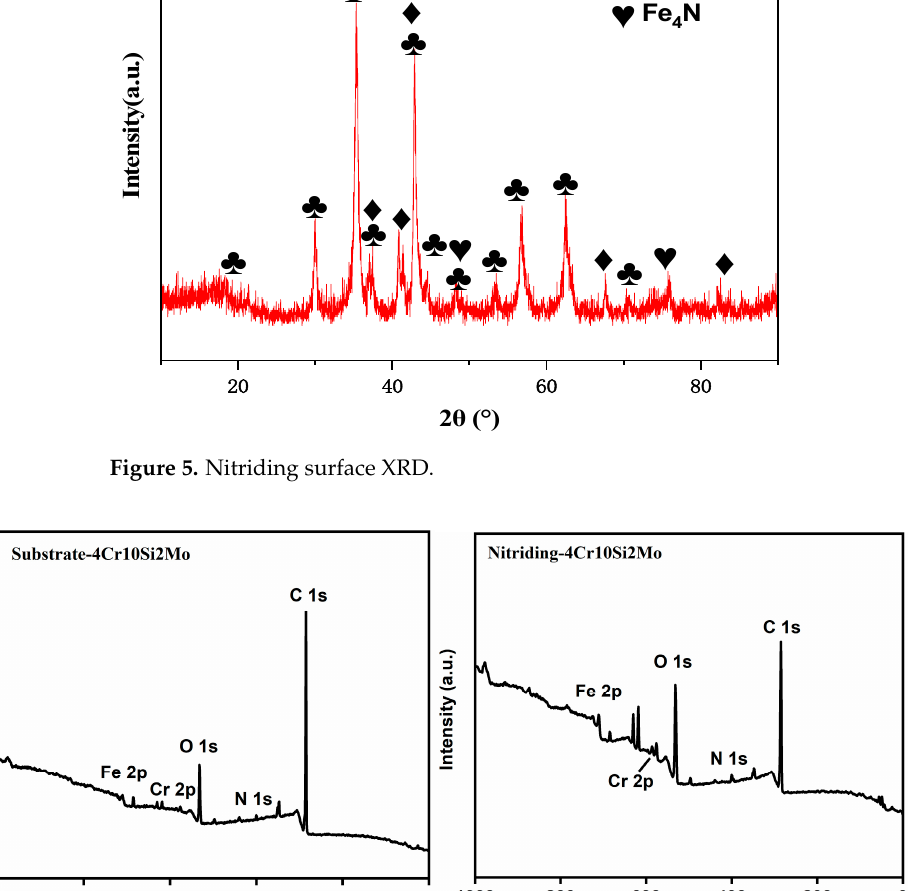
Figure 5. Nitriding surface XRD.